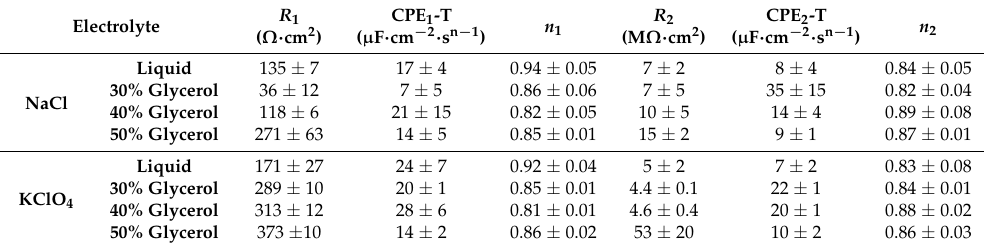
Table 3. Electrochemical parameters obtained from electrochemical impedance spectroscopy (EIS) measurements after fitting to an equivalent circuit, in electrolytes with 0.5% NaCl and 1% KClO 4 . CPE—constant phase elements.